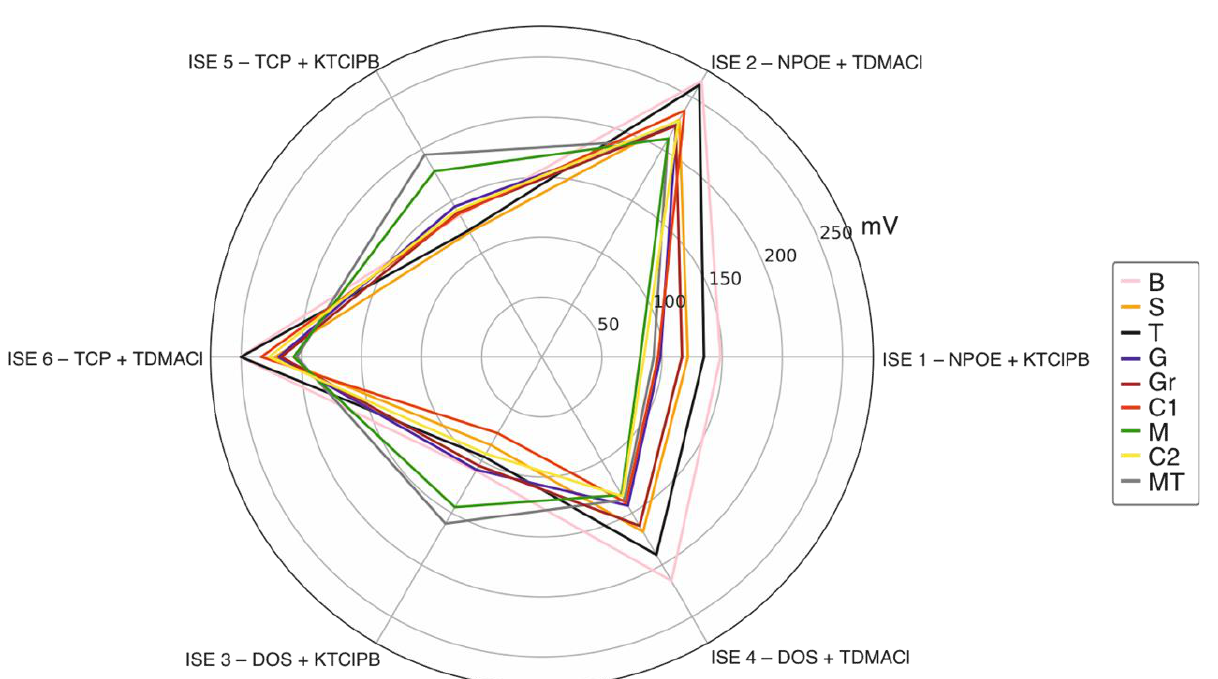
Figure 6. Radar plot of the final potential displayed by each electrode (1–6) in each water sample. Each line connects the data related to the same sample.